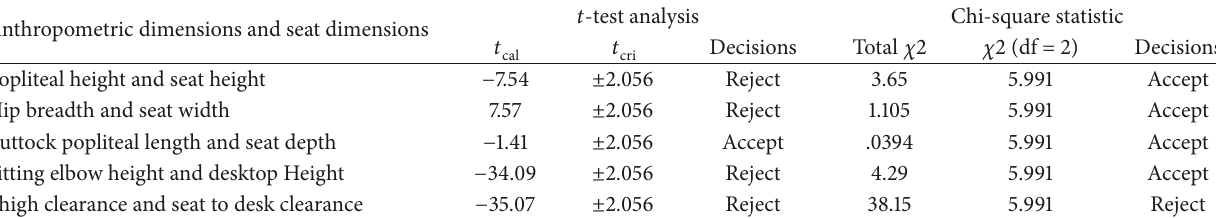
Table 3: 𝑡 -test analysis and chi-square statistic of related anthropometric dimensions and seat dimensions.